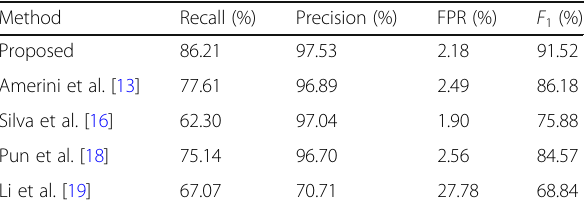
Table 8 Detected results for CMH4 dataset under resizing and